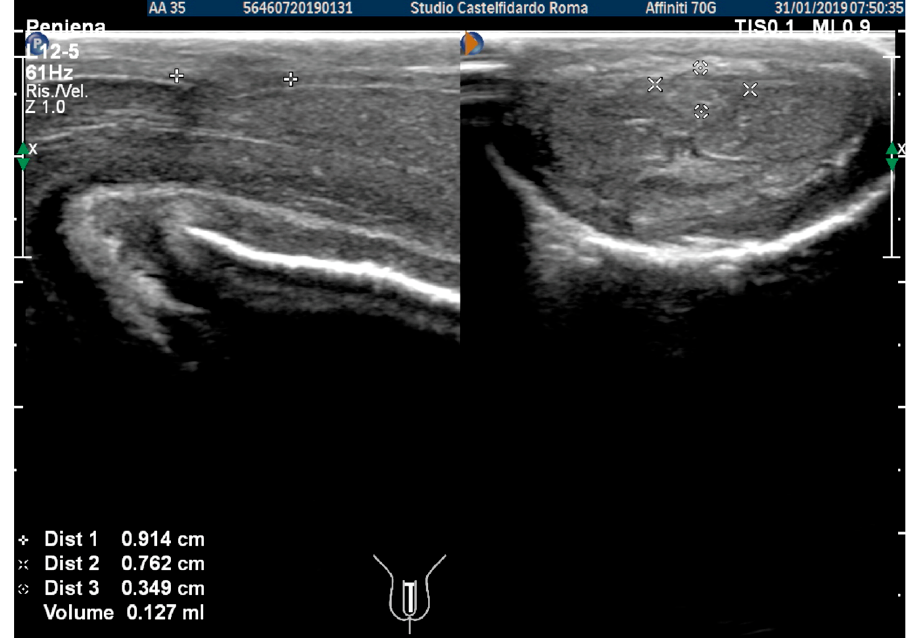
Figure 11. Ultrasonography of the penis after the 2nd therapy cycle (longitudinal and axial views). Compared to its initial measurement, the plaque had therefore undergone an 82.4% cycle of multimodal therapy, the decision was made to continue the same oral and topical treatment for a third cycle, while reducing the pentoxifylline 100 mg injection frequency to one penile peri-plaque injection every other